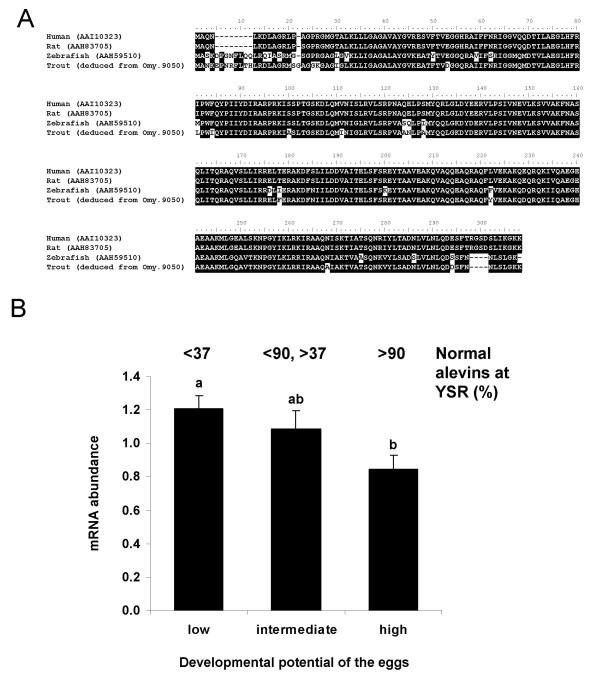
(A) Amino acid sequence alignment of deduced rainbow trout prohibitin 2 (PHB2) with human, rat and zebrafish forms. For each target species, the GenBank accession number of the protein is indicated. (B) Real-time PCR analysis of PHB2 mRNA abundance (mean ± SEM) in eggs of low (n = 10), intermediate (n = 9) and high (n = 10) developmental potential estimated by the percentage normal alevins at yolk-sac resorption. Different letters indicate significant differences between groups at p < 0.05.